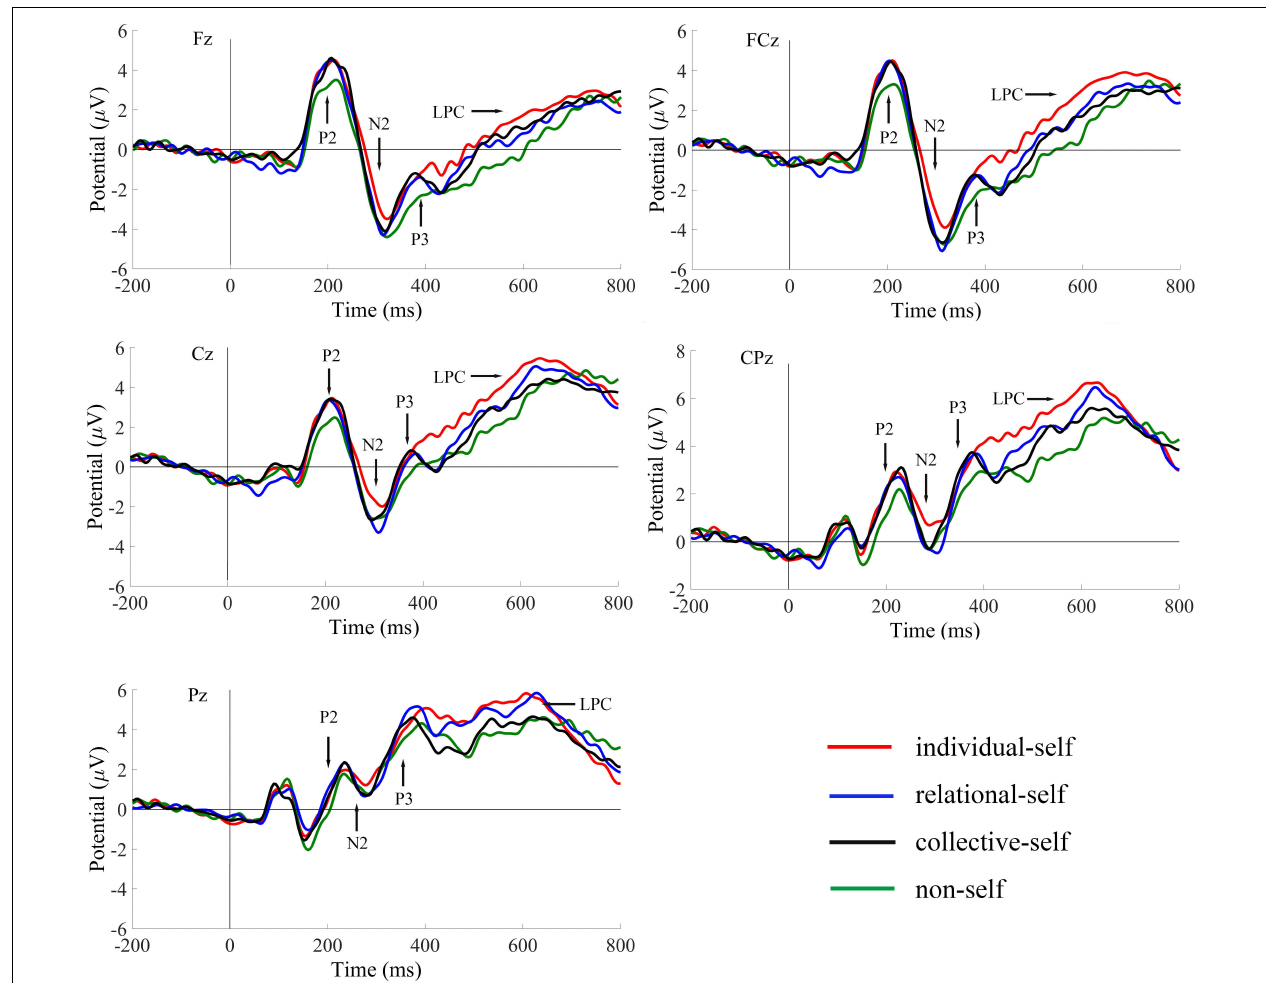
FIGURE 2 | Grand-averaged ERPs for P2, N2, P3, and LPC of the individual self, relational self, collective self, and non-self during the matched condition.